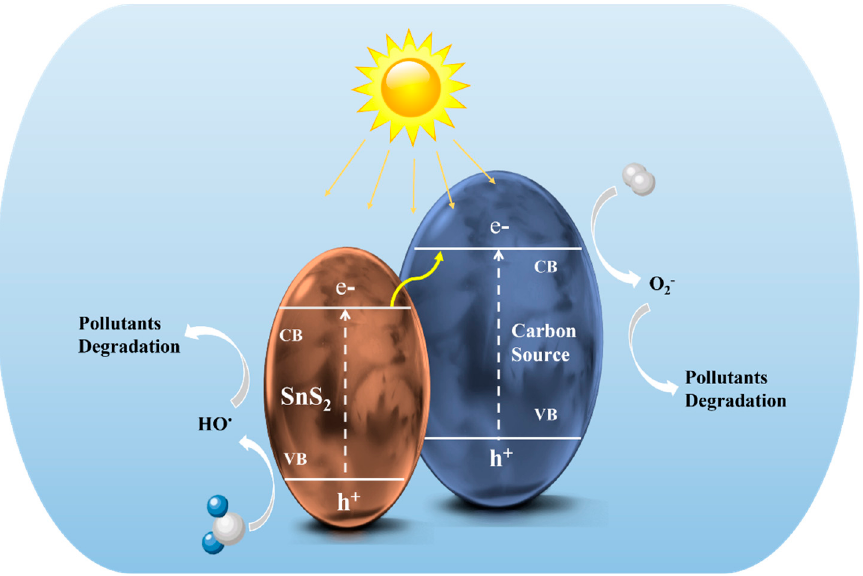
Figure 16. Photocatalytic schematic representation of SnS 2 /Carbon nanomaterials.